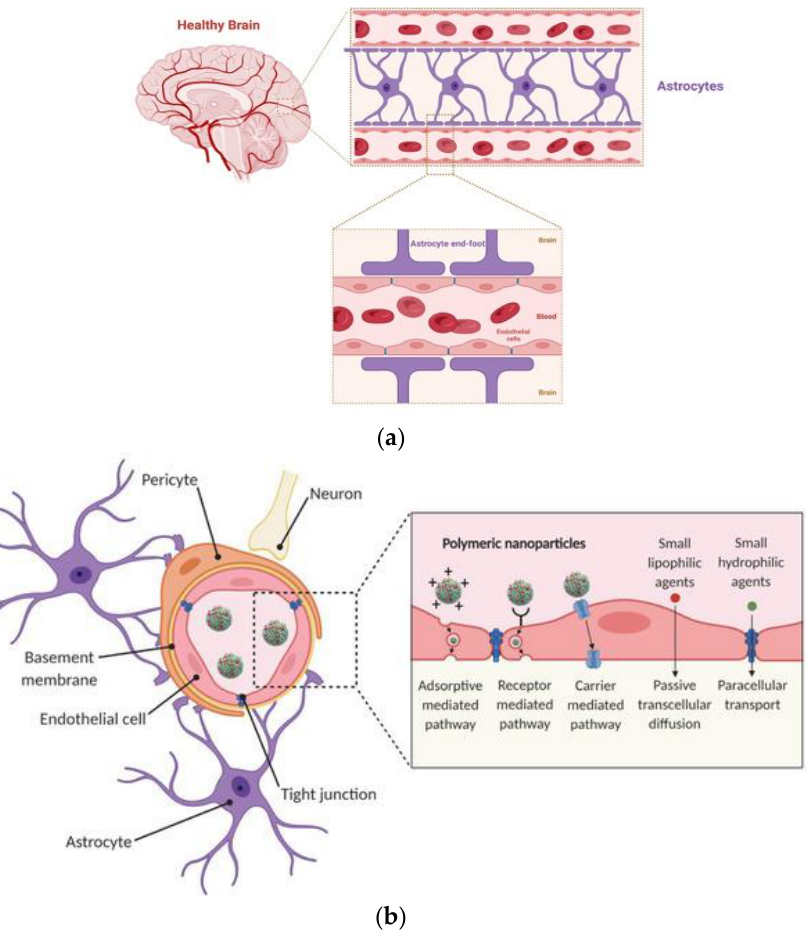
Figure 2. ( a ) Anatomy of blood – brain barrier (created with BioRender.com) and ( b ) transportation of polymeric nanoparticles to the brain via various pathways. Reprinted from Zhang et al. [42]. Copyright © 2021 Advanced Science published by Wiley-VCH GmbH under Creative Common License 4.0.